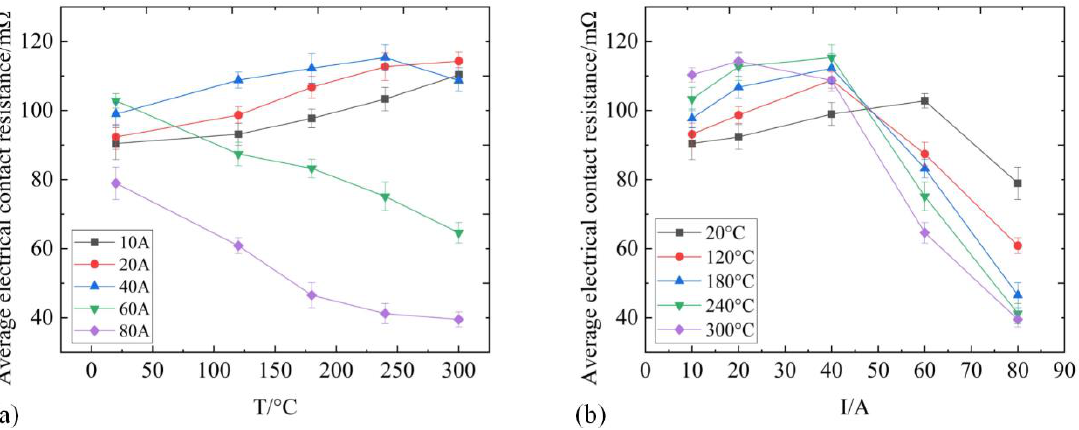
Figure 3. Effect of temperature on the AECR of the C-Cu contacts: ( a ) under different current and ( b ) under different temperature.